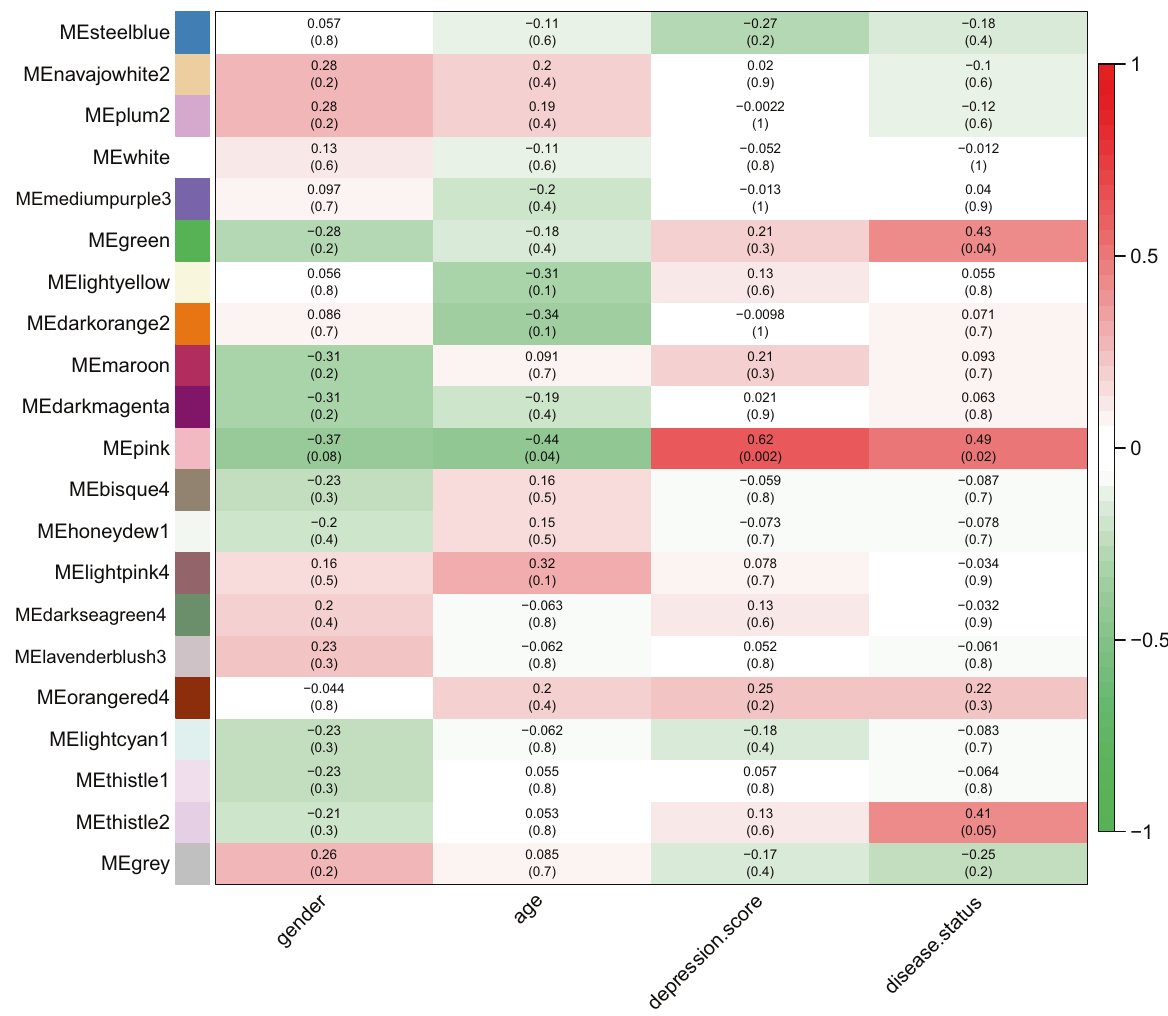
Fig. 3 Relationships of consensus module eigengenes and external trait. Each row in the table corresponds to a consensus module, and each column to a trait. Numbers in the table report the correlations of the corresponding module eigengenes and trait with the P -values printed below the correlations in parentheses. The table is color coded by correlation according to the color